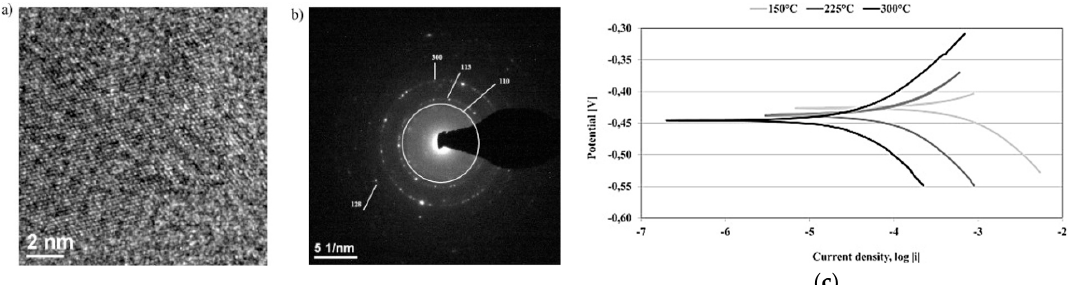
Figure 13. ( a , b ) High ‐ resolution (HRTEM) micrograph of the Al 2 O 3 layer deposited at 300 °C with corresponding SAED pattern; ( c ) Potentiodynamic polarisation curves of the Al 2 O 3 coating of different deposition temperatures tested in 1 ‐ M HCl solution [83].